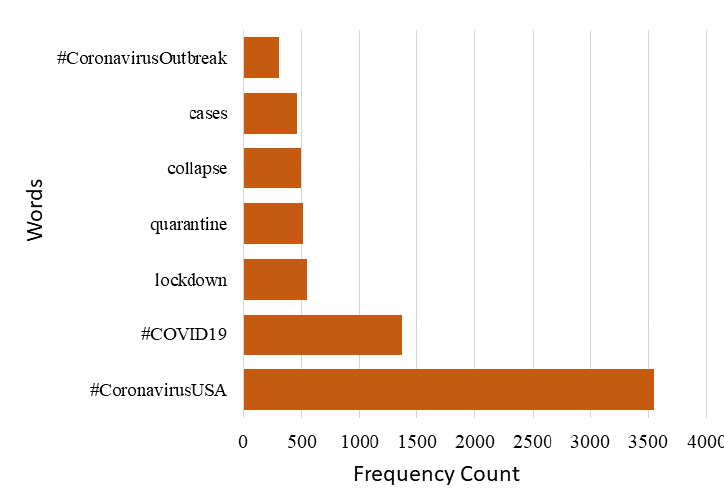
Figure 3. Frequency count of most often used terms in the dataset.